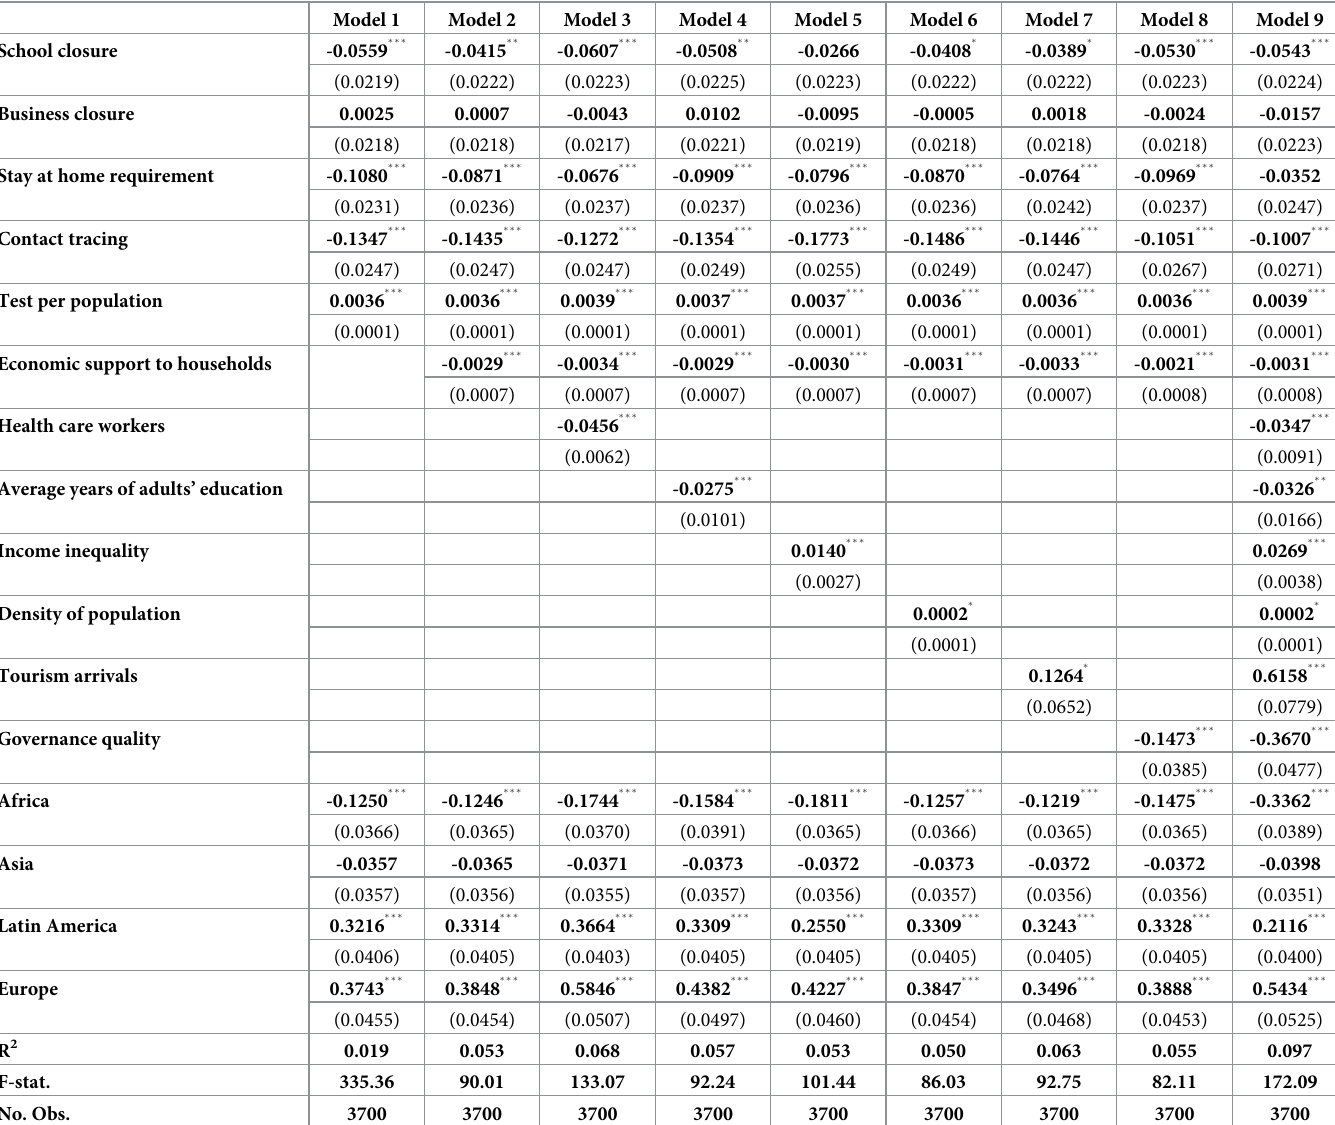
Table 2. Robustness test based on the scaled debiased